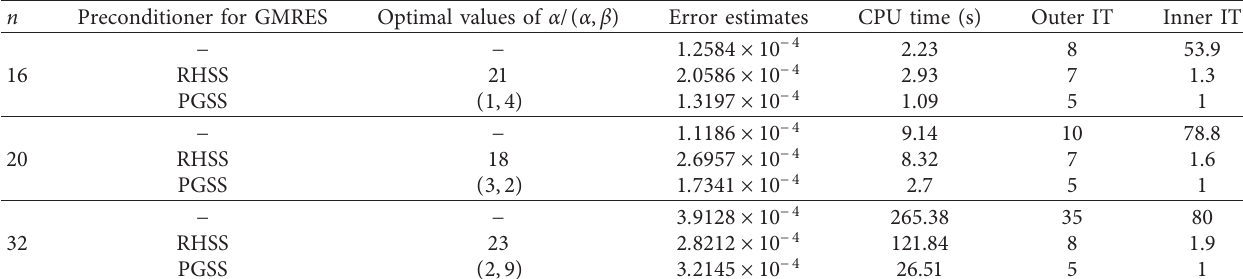
Table 12: Numerical results of preconditioned inexact Newton methods for v � 1 and η � 0.1.